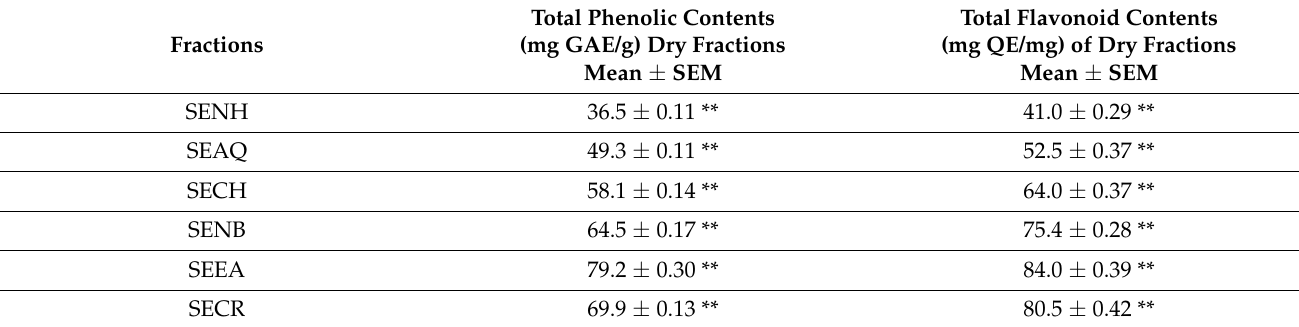
Table 2. Total phenols and flavonoids estimation of S. edelbergii